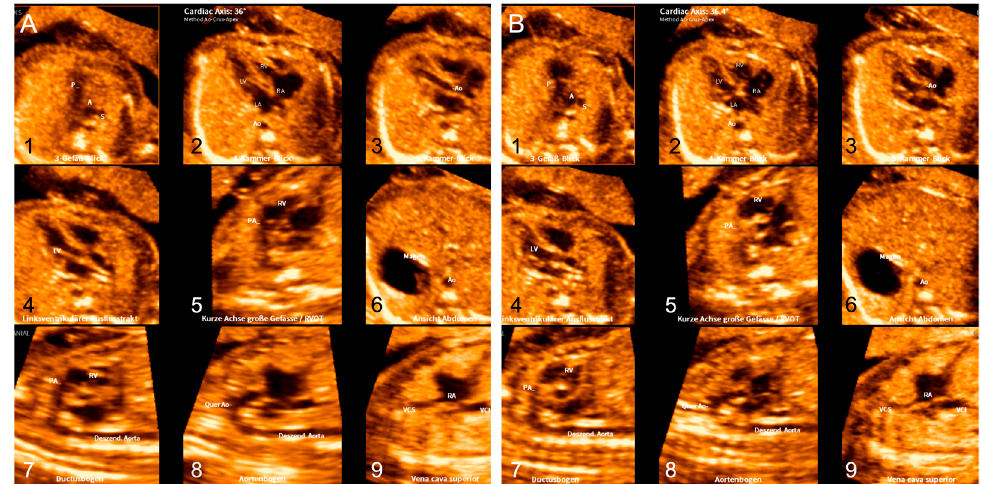
Figure 1. The nine diagnostic planes of the fetal heart reconstructed by FINE standard mode ( A ) and FINE static mode ( B ). (1) Three-vessel–trachea view; (2) four-chamber view; (3) five-chamber view; (4) left ventricular outflow tract; (5) short-axis view of great vessels/right ventricular outflow tract; (6) abdomen/stomach; (7) ductal arch; (8) aortic arch; and (9) superior and inferior vena cava.